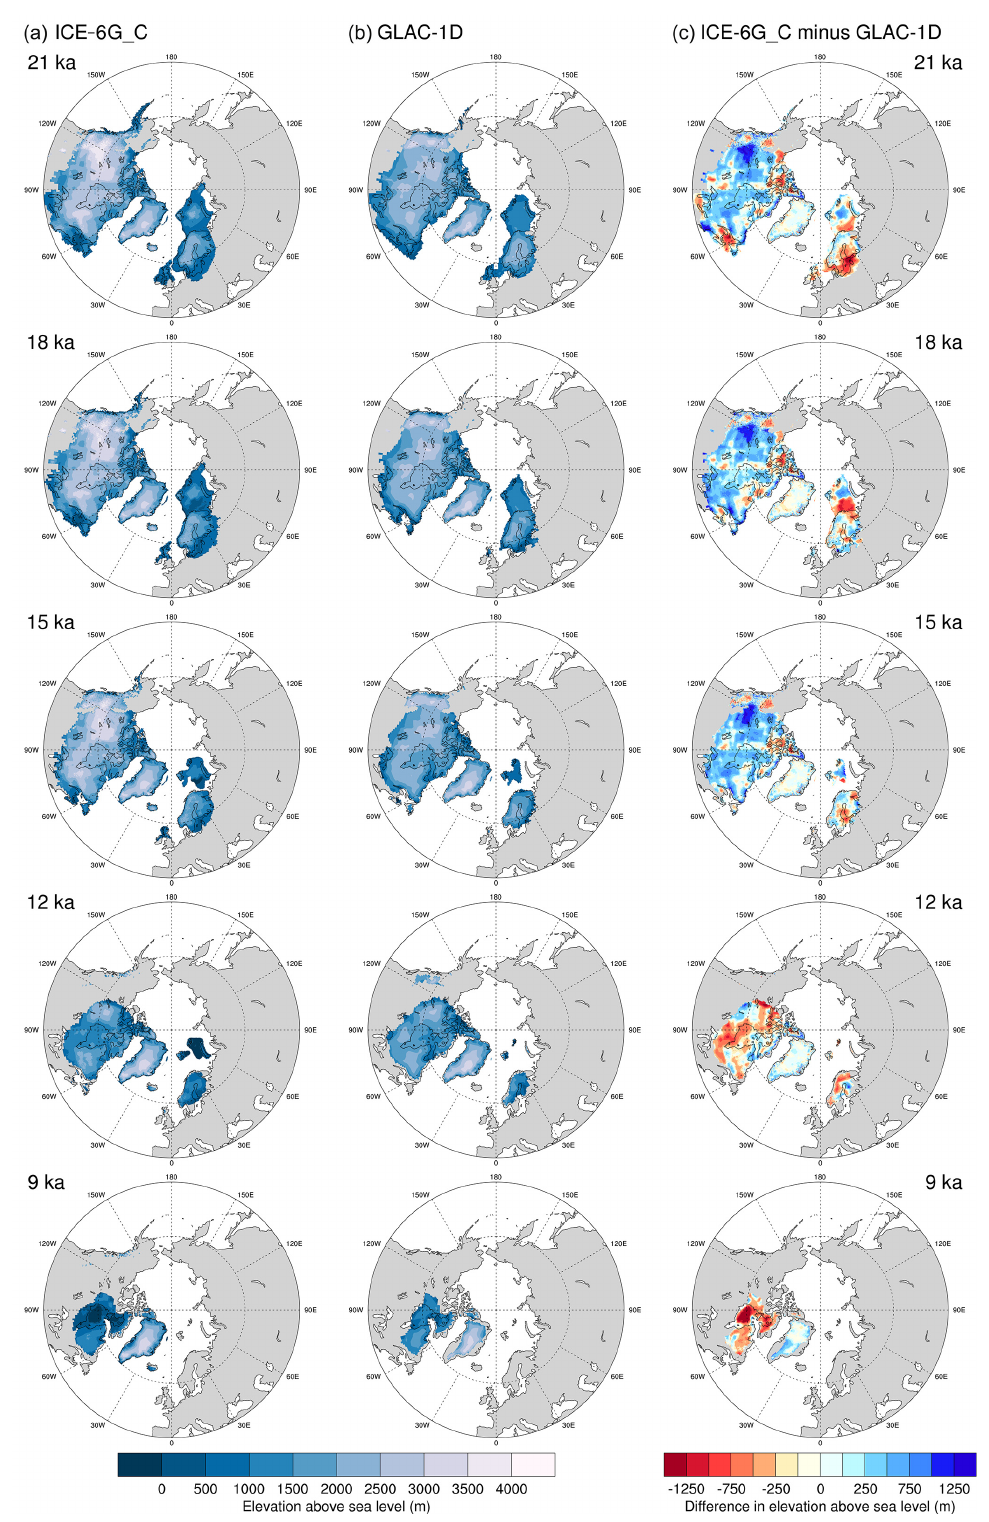
Figure 2. Northern Hemisphere ice sheet elevation at 21, 18, 15, 12 and 9ka for (a) the ICE-6G_C reconstruction at 10arcmin horizontal resolution, elevation is plotted where the fractional ice mask is more than 0.5 (Peltier et al., 2015); (b) the GLAC-1D reconstruction at 1 ◦ (longitude) × 0.5 ◦ (latitude) horizontal resolution, elevation is plotted where the fractional ice mask is more than 0.5 (Briggs et al., 2014; Tarasov et al., 2012; Tarasov and Peltier, 2002; this study); (c) the difference in elevation above sea level between the two reconstructions where there is ice present in both (ICE-6G_C minus